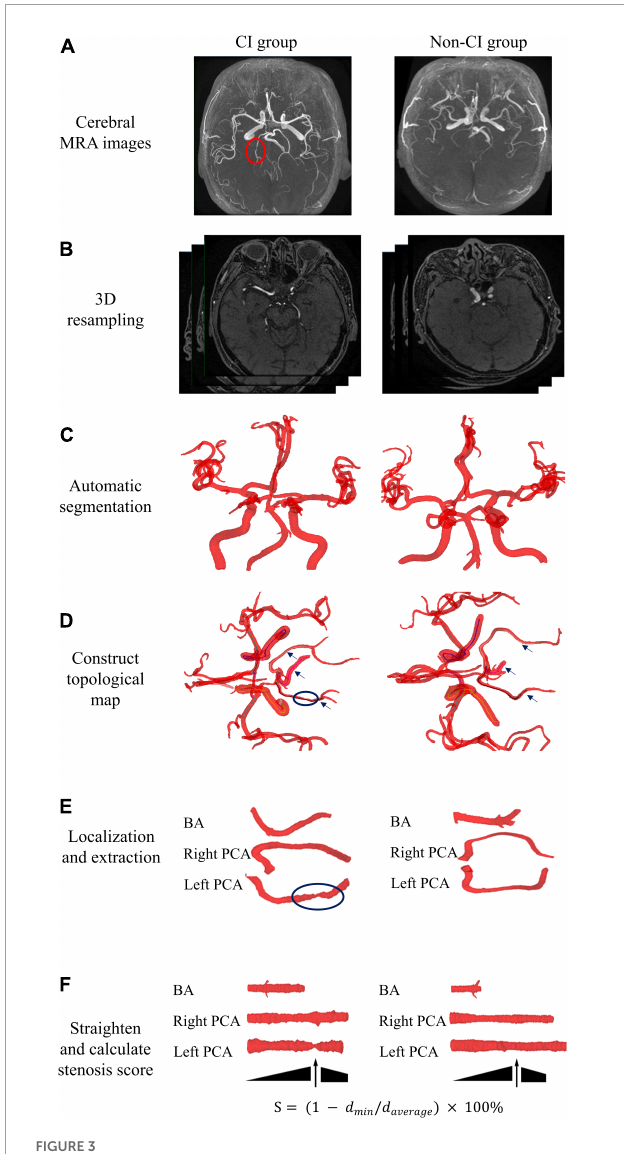
FIGURE3 Overall workflow of automated quantitative analysis of posterior circulatory artery in cerebral MRA. Representative cerebral MRA images at CI and non-CI group. (A) Cerebral MRA data were collected. (B) 3D resampling of raw images was used to enhance axial resolution of 3D TOF MRA. (C) Automatic segmentation of cerebral arteries. (D) Construction of a topological map based on centerlines. (E) Automated localization and extraction of posterior circulatory artery. (F) Computational straightening and calculation of the stenosis score for target artery. BA, basilar artery; PCA, posterior cerebral artery; 3D TOF MRA, three dimensional time-of-flight magnetic resonance